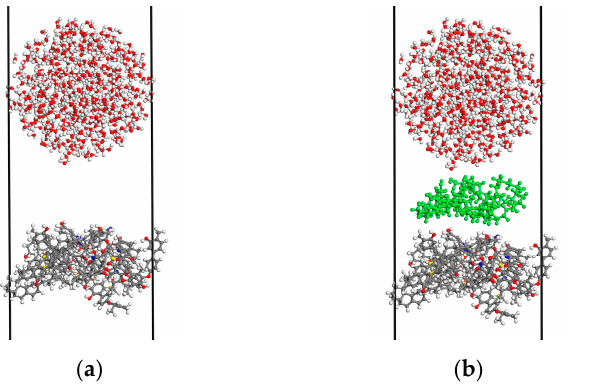
Figure 3. Di ff erent system models: ( a ) H 2 O/bituminous coal; ( b ) H 2 O/AEO-9/bituminous coal. Figure 3. Different system models: ( a ) H 2 O/bituminous coal; ( b ) H 2 O/AEO-9/bituminous